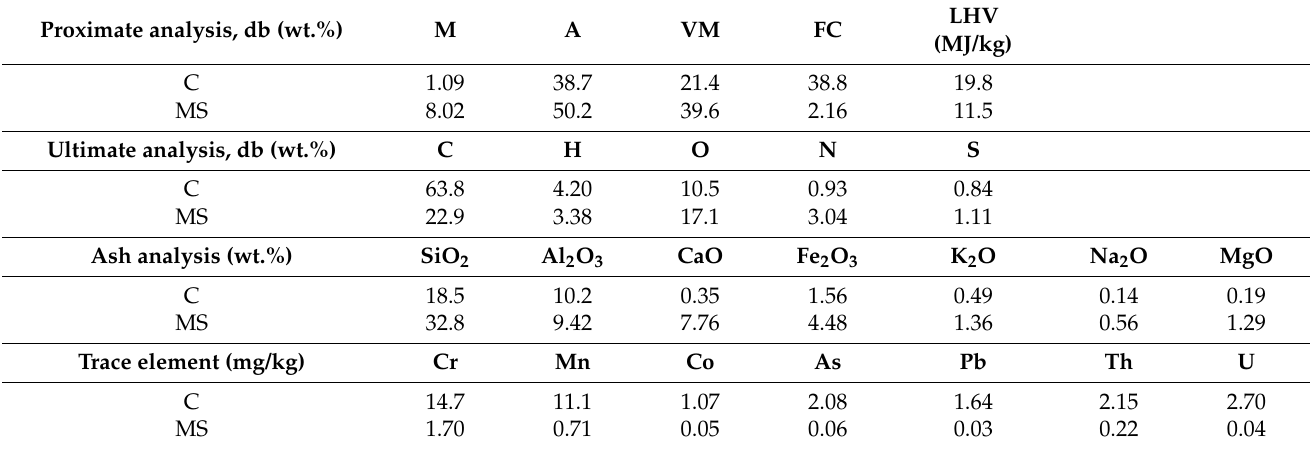
Table 1. The physic-chemical characterizations of the coal (C) and municipal sludge (MS). Proximate analysis, db